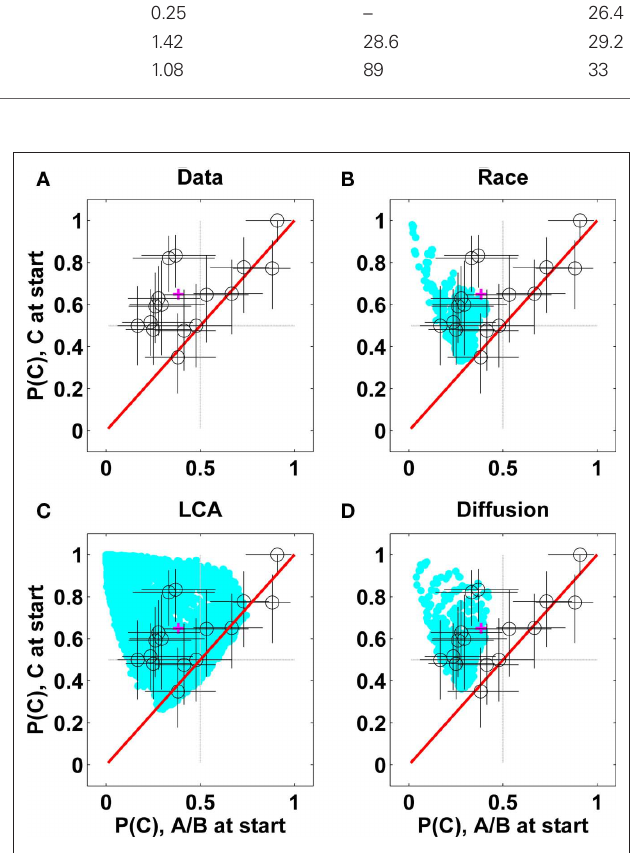
Figure 9 | individual choice for the dissimilar alternative, P(C), in the correlation condition of the experiment (upper-left) and in the models (others panels). Open-circles show the fraction of C-choices for each participant (error bars are 90% confidence intervals). The pink cross at (0.35, 0.65), indicates where the preference of a perfect integrator should be, based on the input statistics. The model predictions are shown with